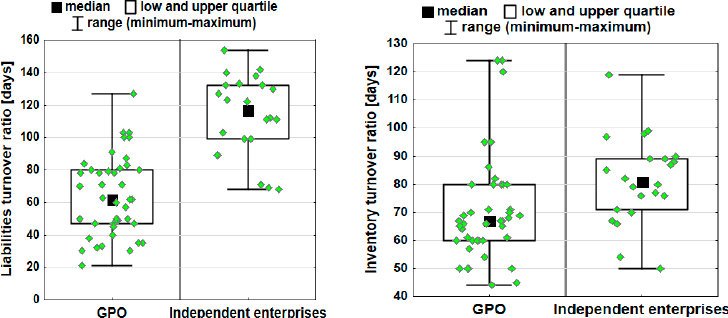
Figure 5. Positional statistics for liabilities and inventory turnover ratio in the compared groups. Source: author’s calculations and studies.